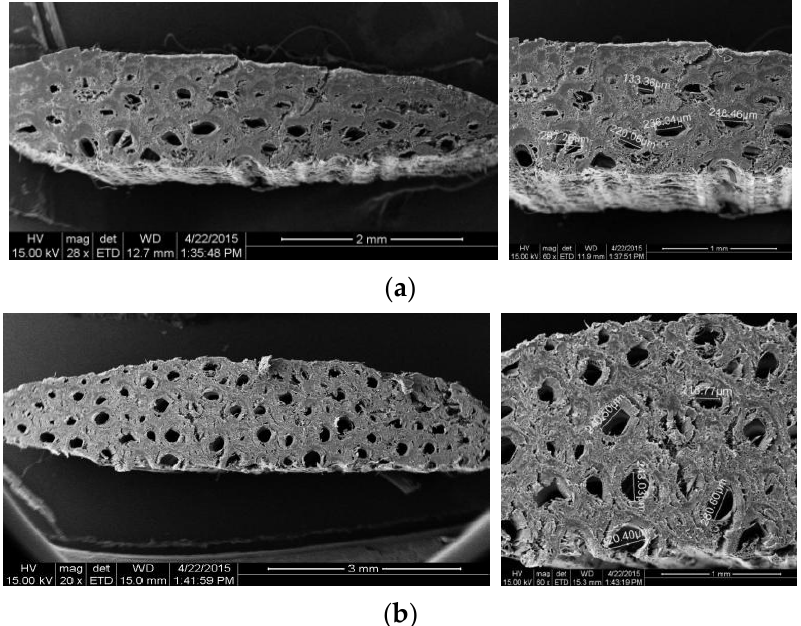
Figure 7. SEM images of typical cross ‐ sections of fractured surfaces of bast ( a ) and core ( b ) rattan strip tested in tension.